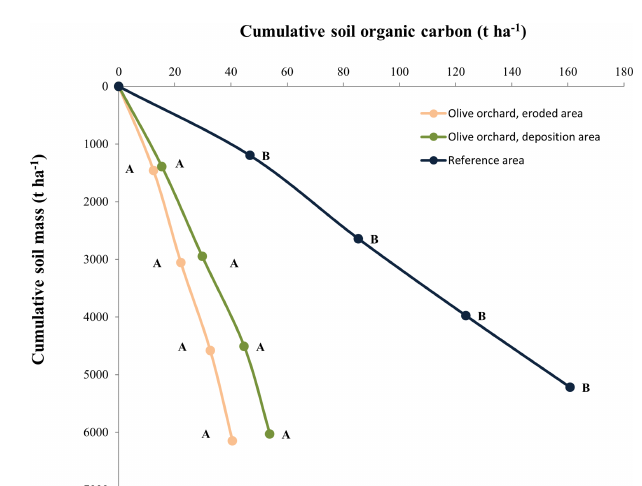
Table 5. Results of the two-way ANOVA of some physical and chemical soil properties, comparing eroded vs. deposition areas in the olive orchard. NS stands for not